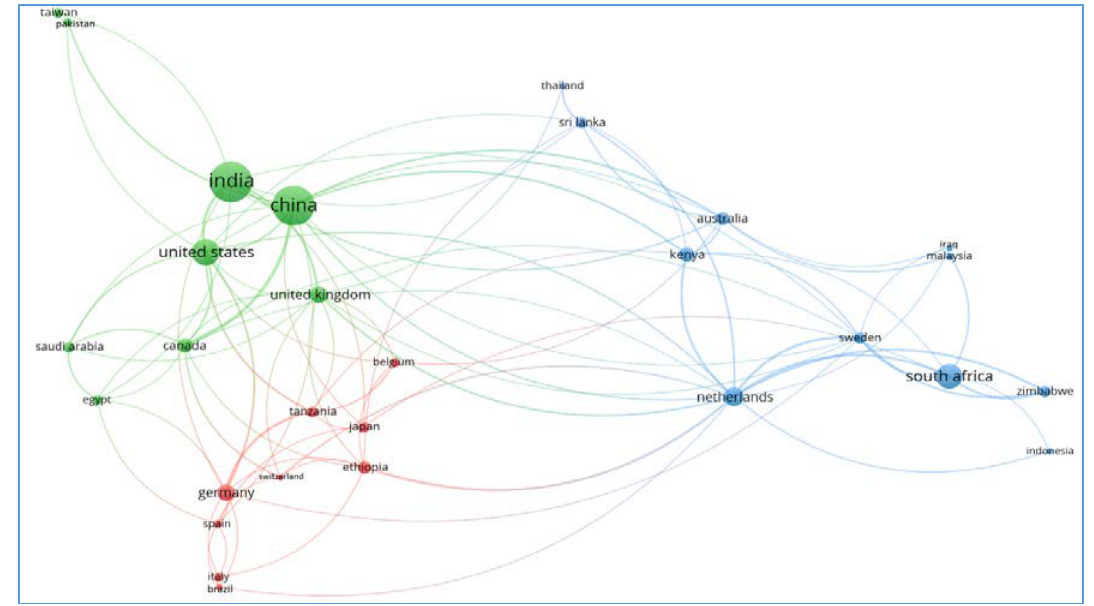
Figure 4. Main relationships between countries in RWHI research.